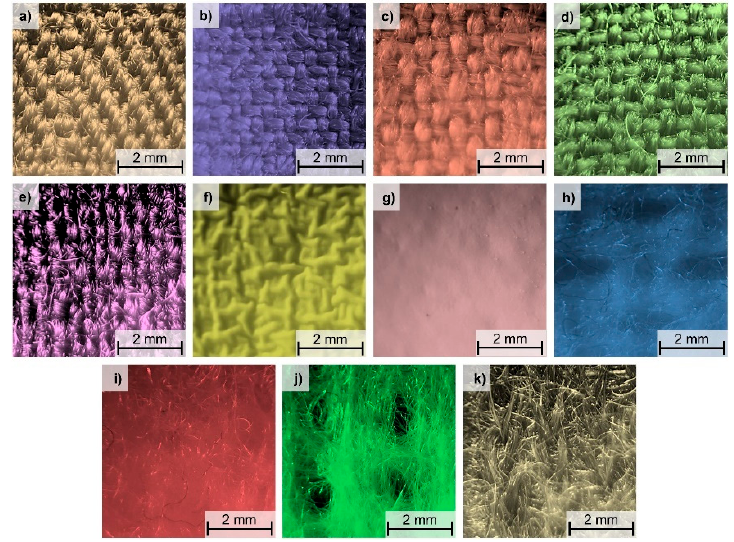
Figure 2. Optical microscopy images: ( a ) woven fabric 1; ( b ) woven fabric 2; ( c ) woven fabric 3; ( d ) woven fabric 4; ( e ) woven fabric 5; ( f ) membrane 1; ( g ) membrane 2; ( h ) nonwoven fabric 1; ( i ) nonwoven fabric 2; ( j ) nonwoven fabric 3; ( k ) nonwoven fabric 4.